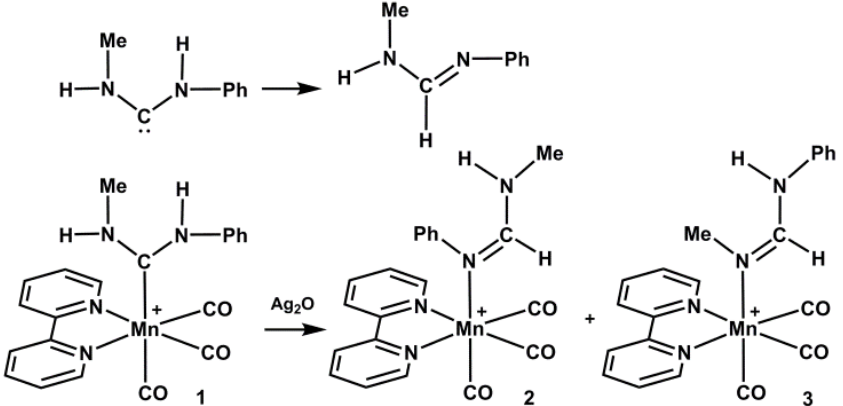
Scheme 1. Transformation of free and coordinated diaminocarbenes into formamidines.